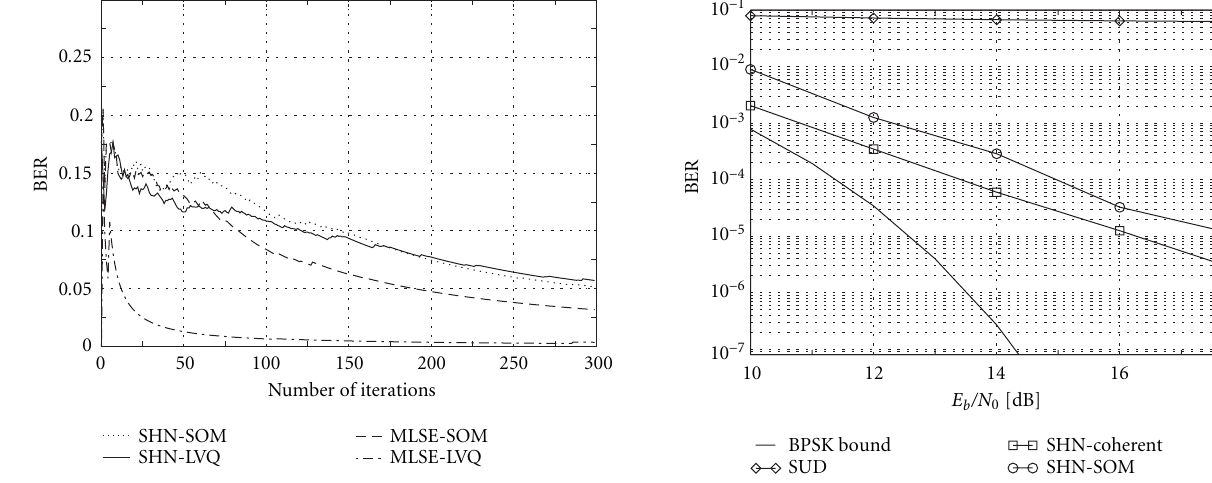
Figure 9: The HPLOS channel with extended Gold